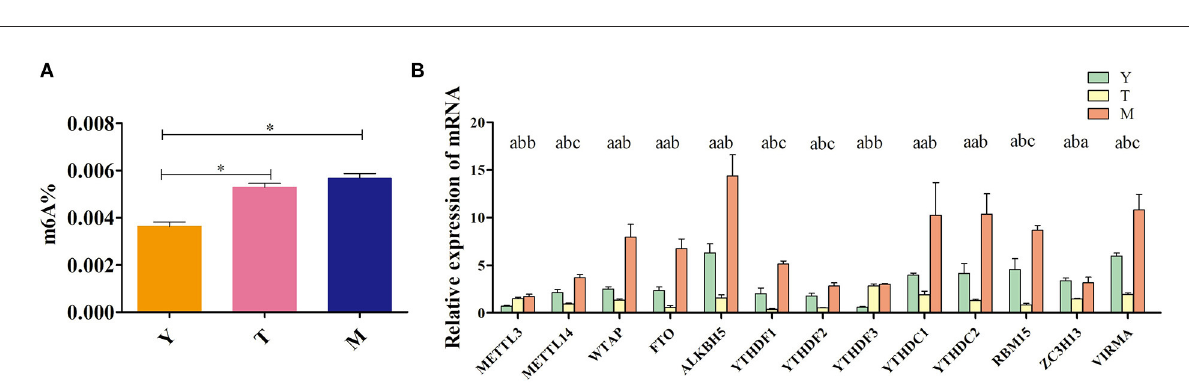
FIGURE2 Analyses of m 6 A levels in yak and cattle-yak testicular tissues. (A) Overall levels of testis tissue methylation. Y: 18-months-old yak, T: cattle-yak, M: 5-years-old yak, ** P < 0.01, * P < 0.05. (B) Methylation-related enzyme expression in the indicated yak groups. Different lowercase letters correspond to significant differences among groups ( P < 0.05), whereas identical letters indicate a lack of any significant differences ( P >